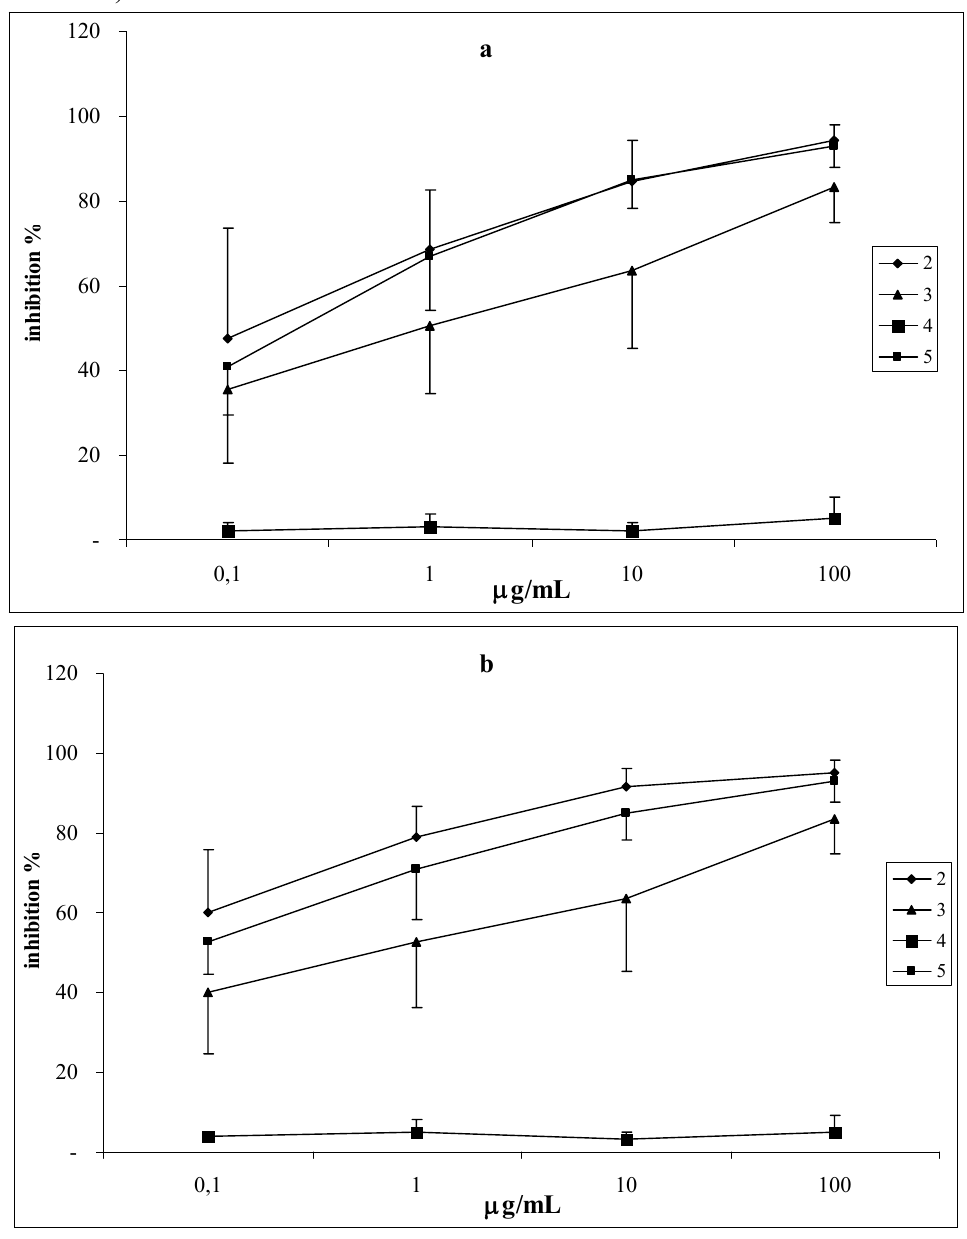
Figure 7 . Inhibitory effects of coumarins on CL emission from resting (a) and PMA- stimulated (b) human isolated PMNs. Values are expressed as percent inhibition (mean±S.D.).